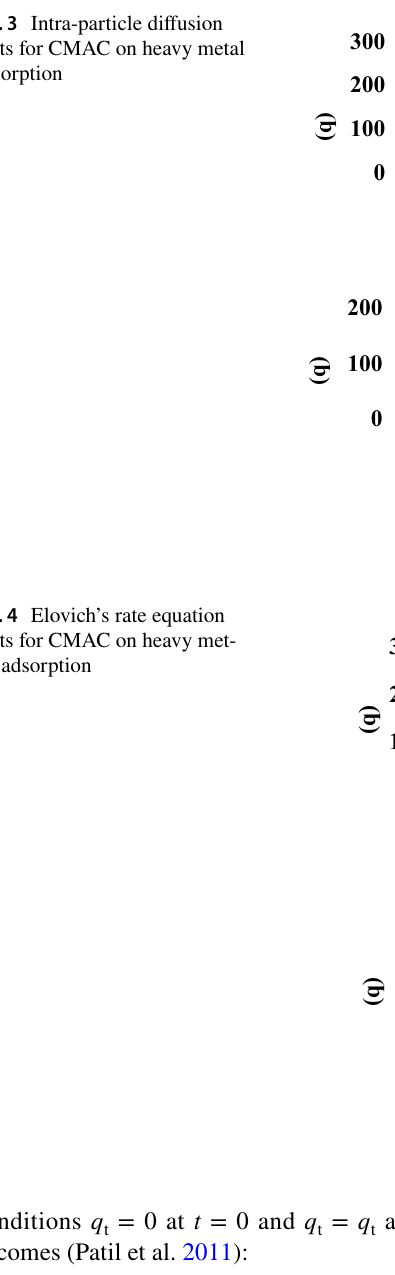
Fig. 3 Intra-particle diffusion plots for CMAC on heavy metal adsorption